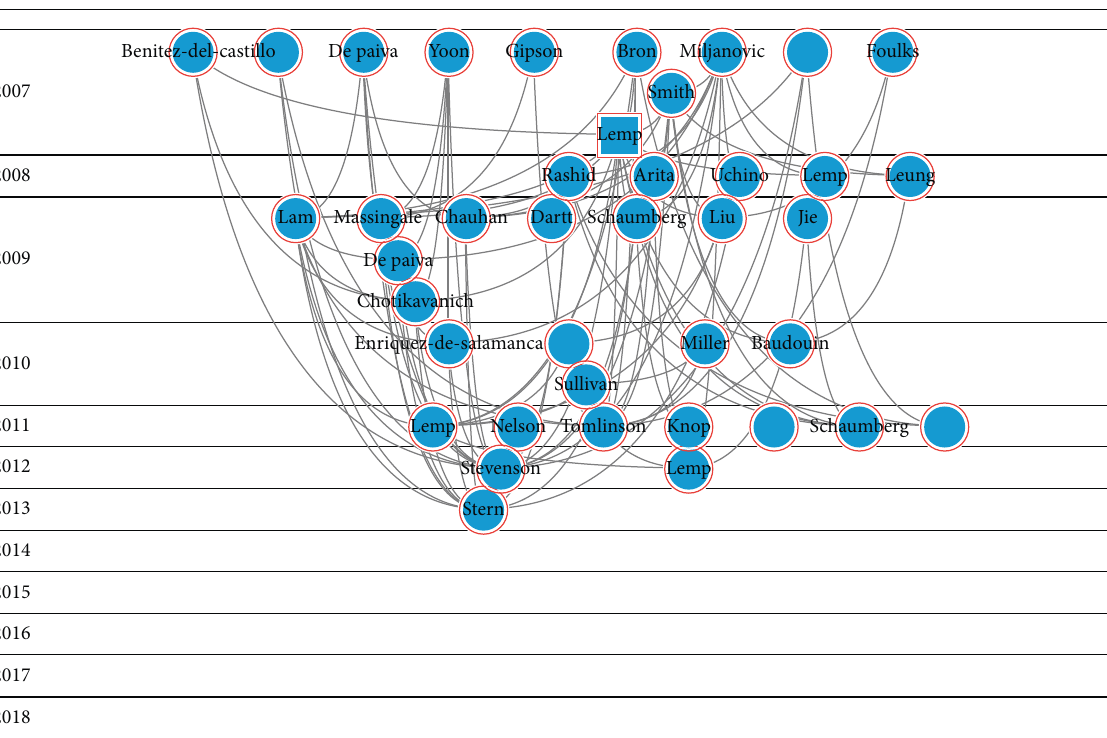
Figure 2: Citation network of cluster